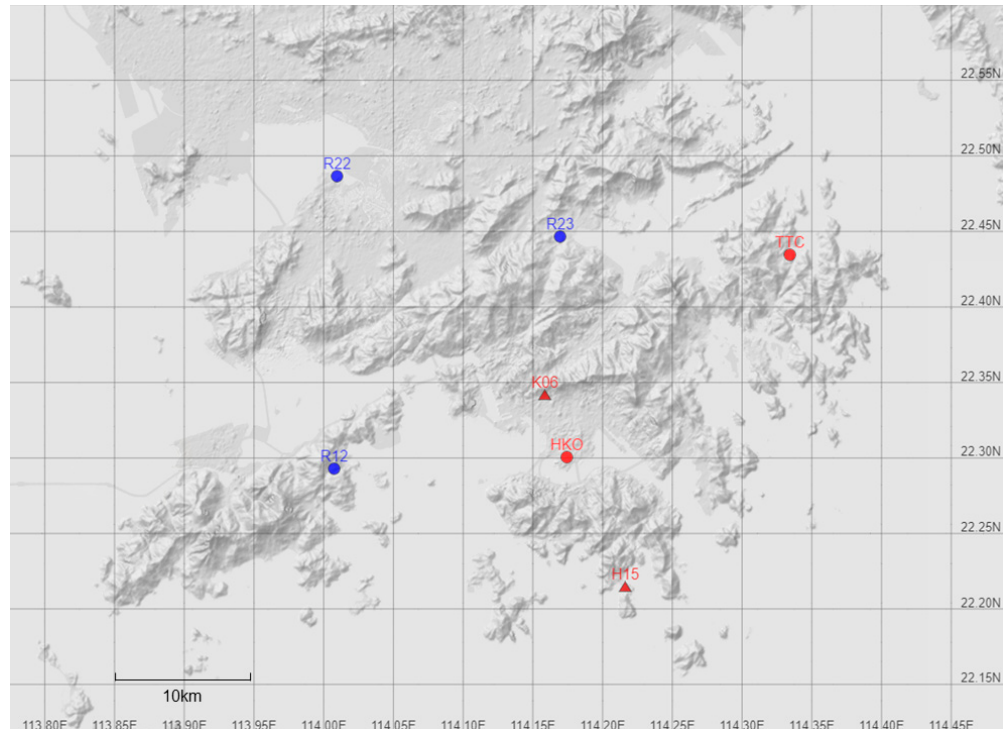
Figure 1. The locations of the rain gauges used for forecast verification (FCV).